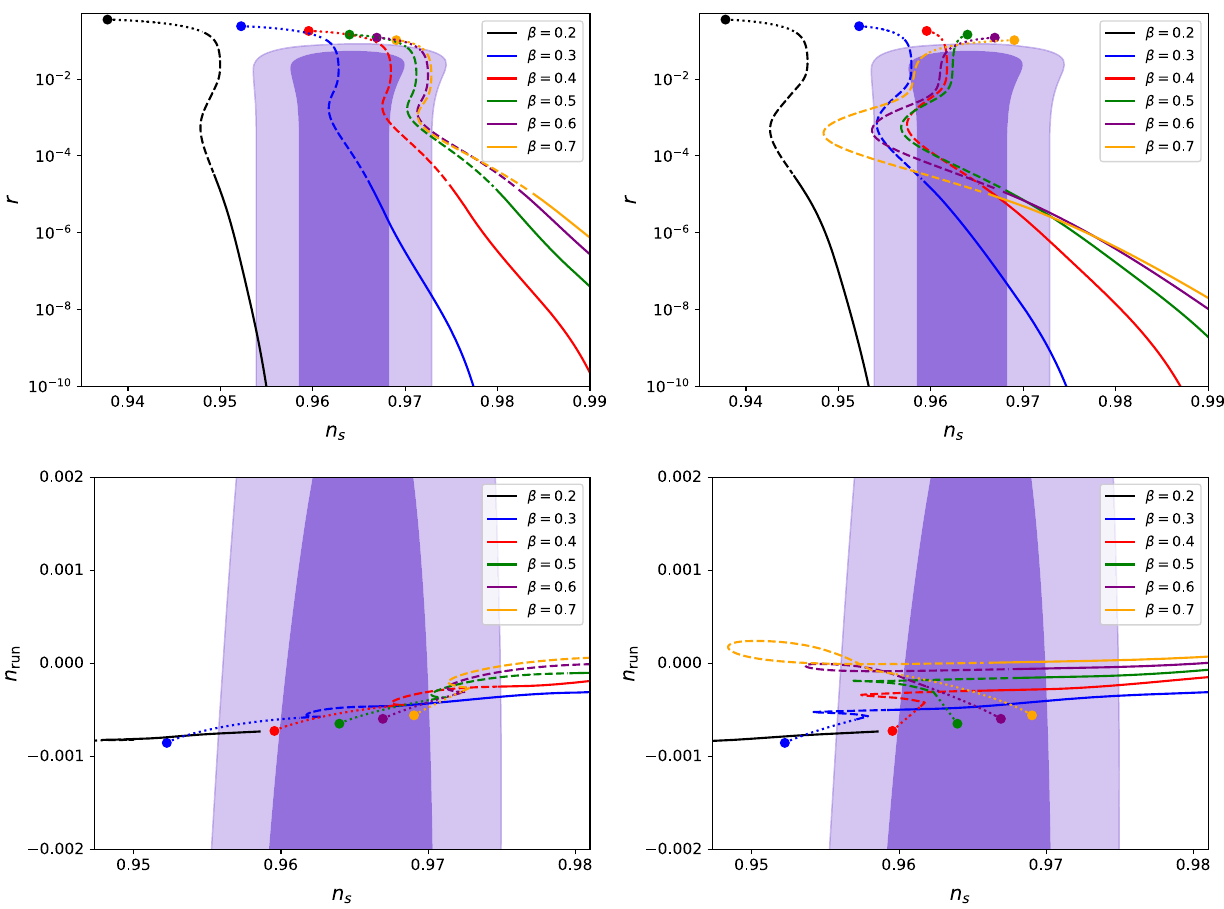
Fig. 1 Predictions of n s − r and n s − n run planes for the β -exponential model with Γ = C φ T 3 /φ 2 . We have chosen fixed values of β while considering λ = 0 . 05 (left panels) and λ = 0 . 07 (right panels), with the